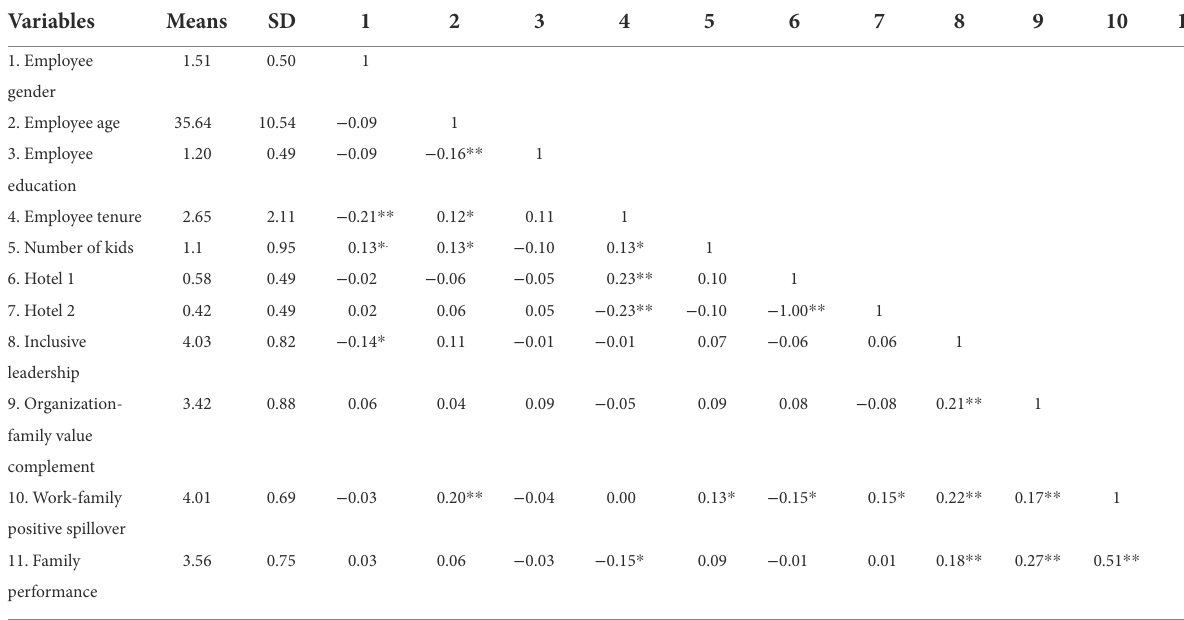
TABLE 2 Means, standard deviations, correlations, and